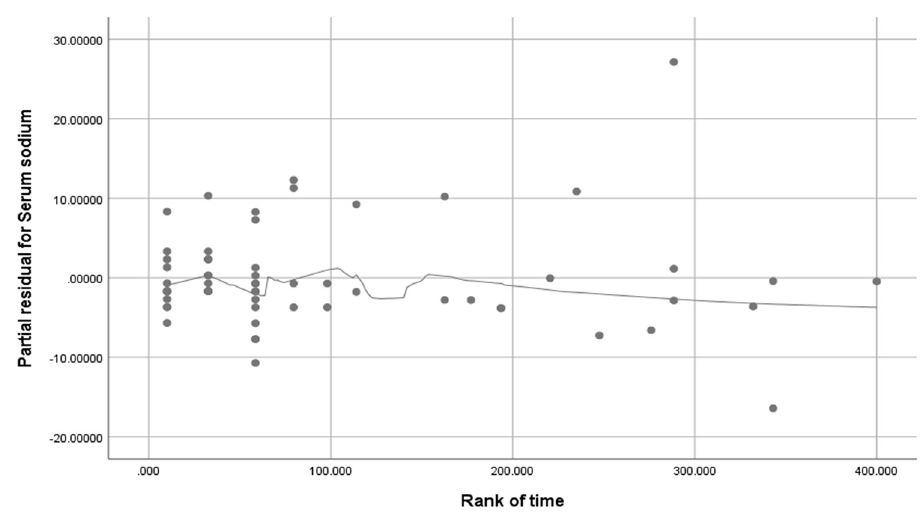
Fig 4. The smooth curve residual diagram of Schoenfeld’s residual with